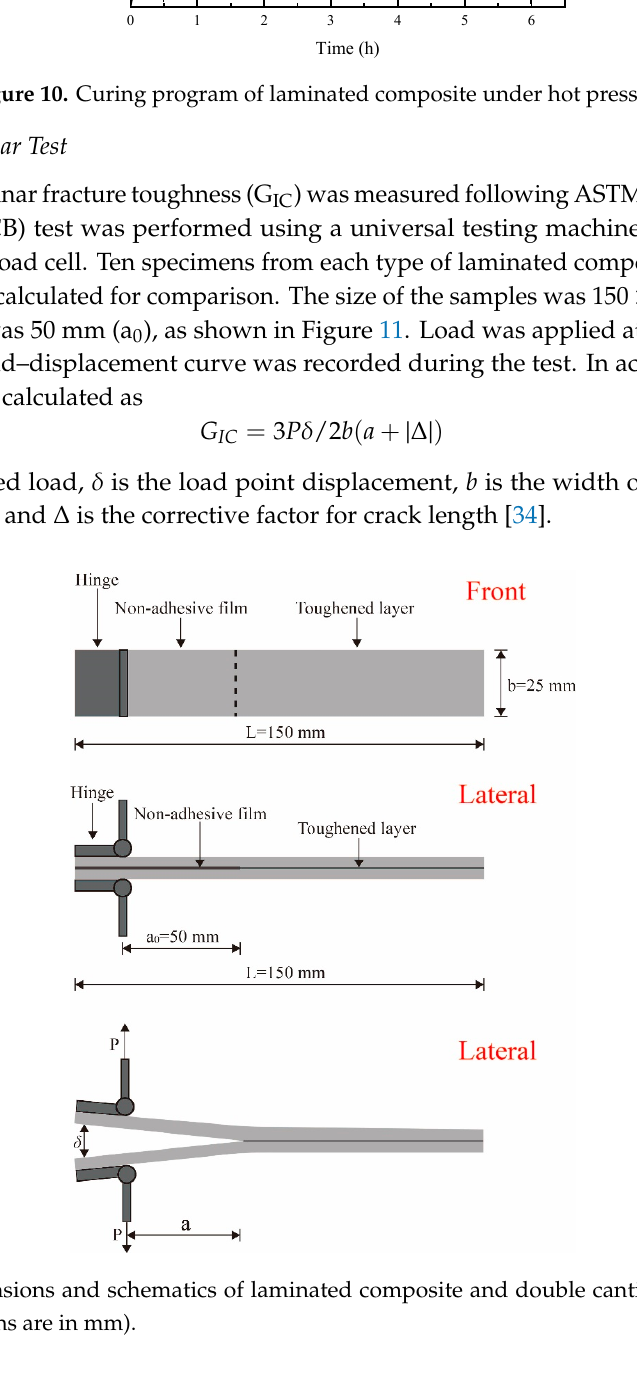
Figure 10. Curing program of laminated composite under hot pressing.